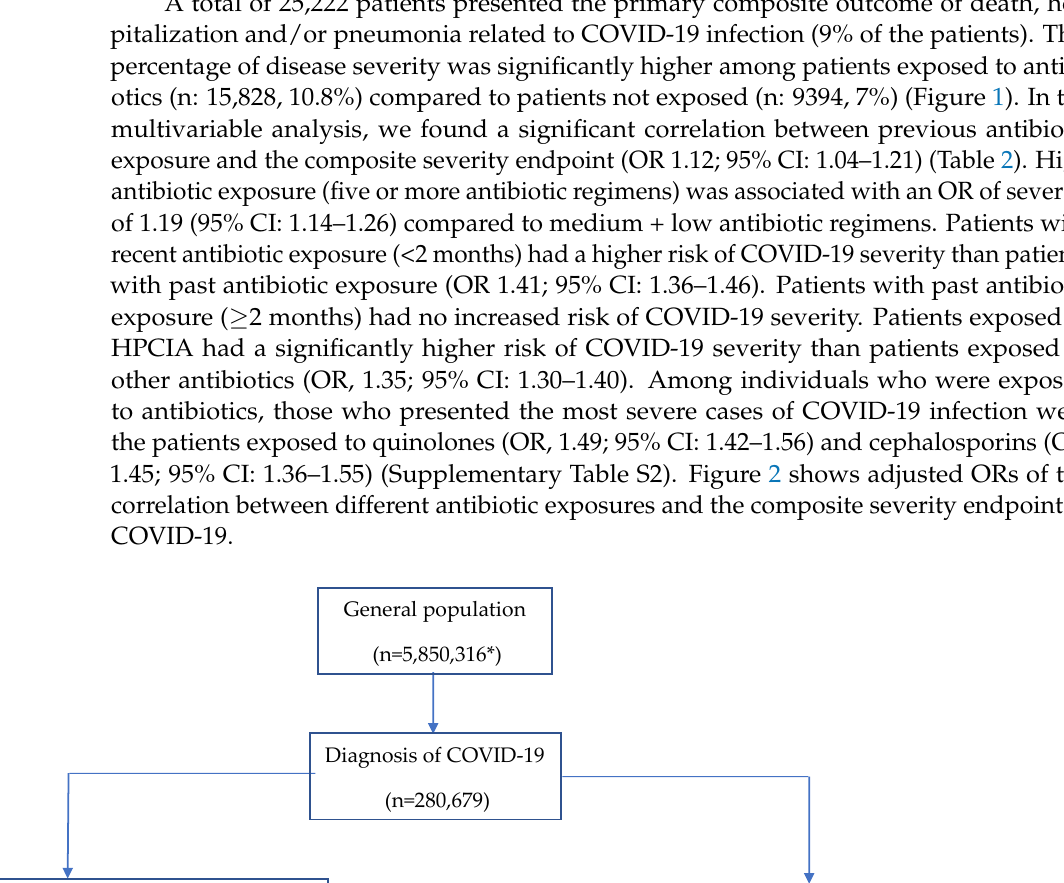
the table: smoking status, body mass index, comorbidities of interest, concomitant medication. Final set of predictors se- lected by means of AIC-based stepwise algorithm, † Compared to all other individuals exposed to antibiotics.